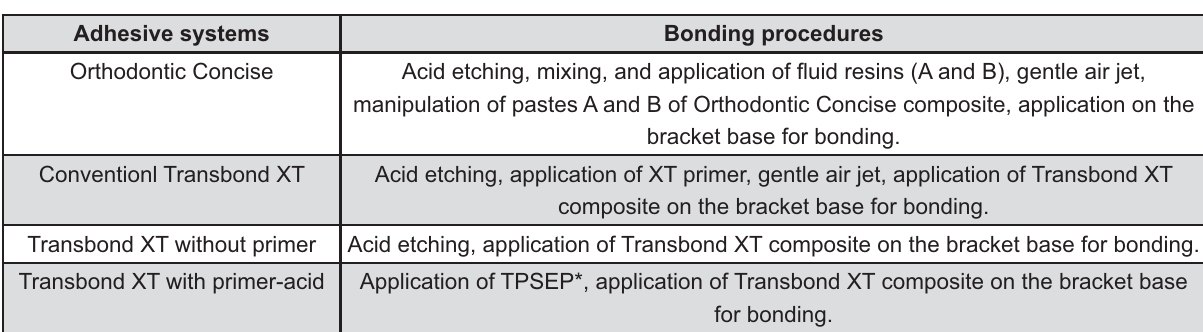
Adhesive systems